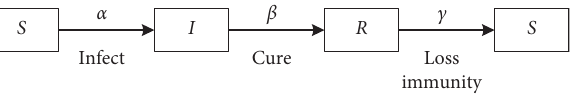
Figure 2: Infectious mechanism of